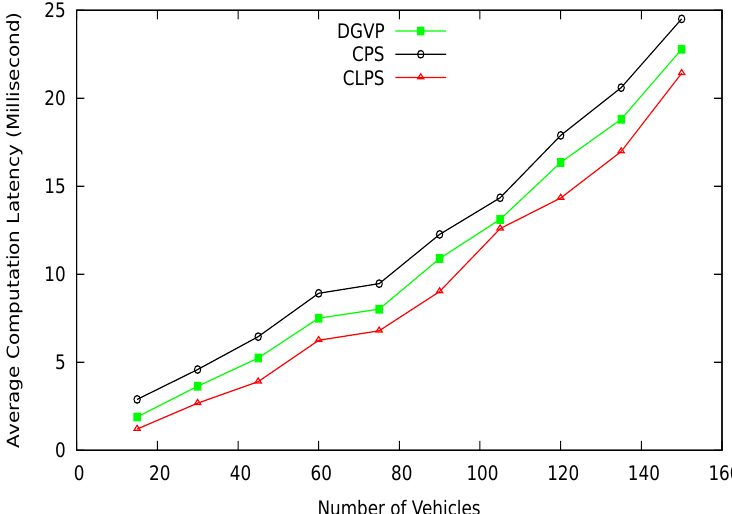
Figure 26. Computation Latency (MS) at different vehicle traffic